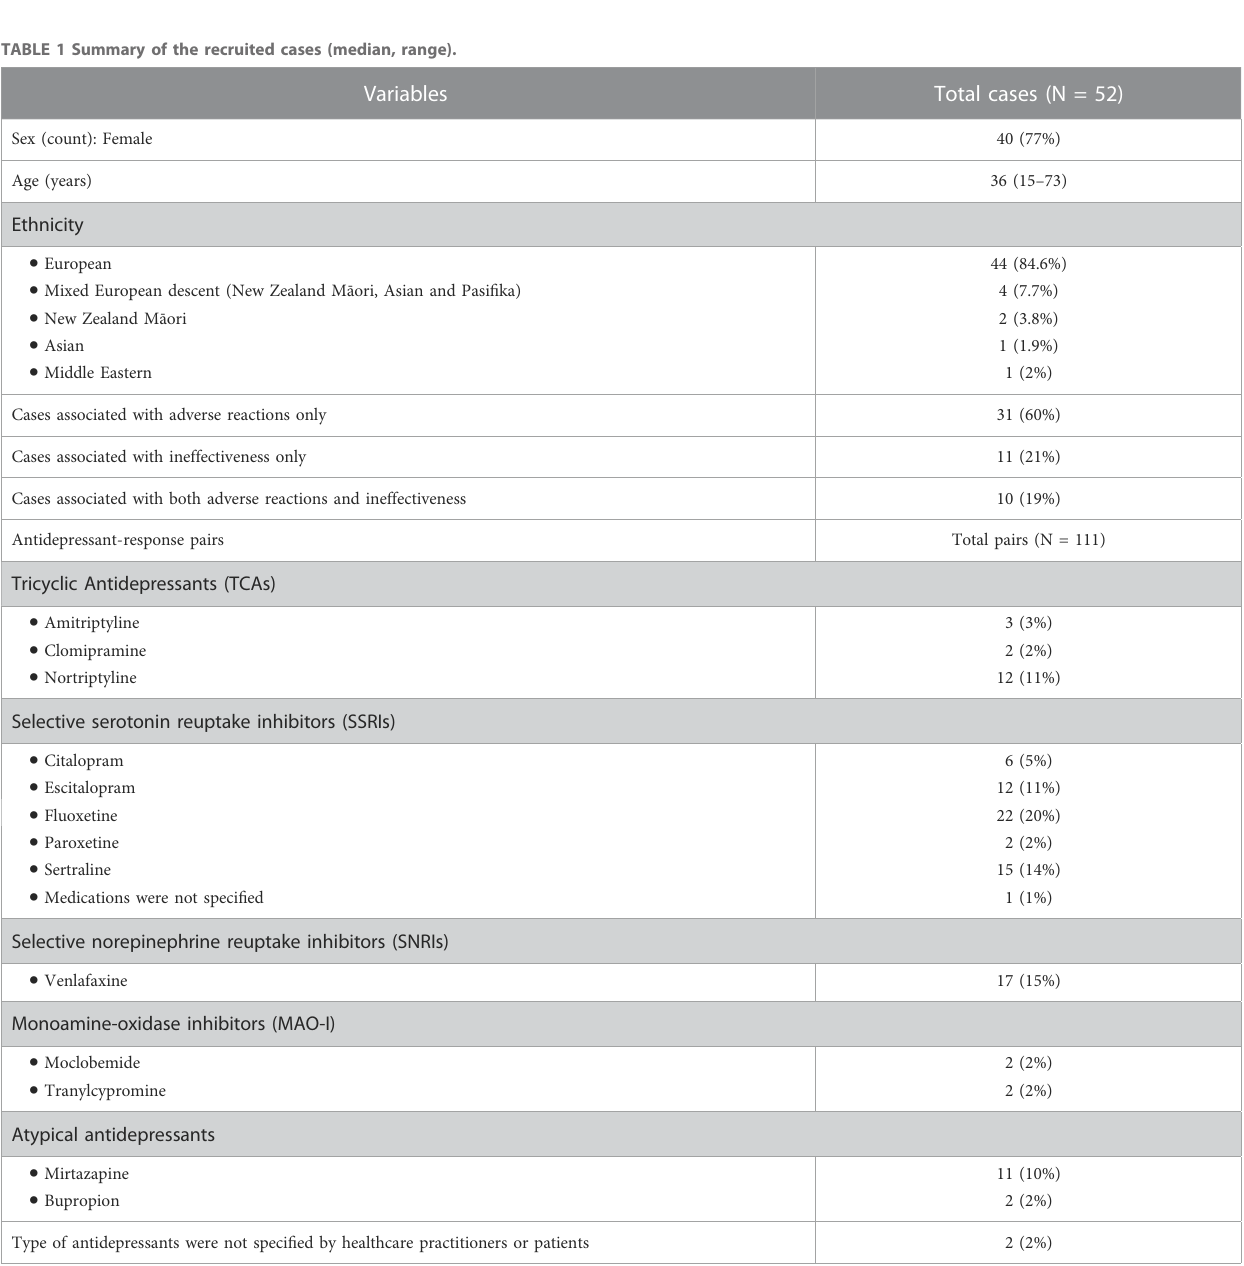
TABLE 1 Summary of the recruited cases (median,